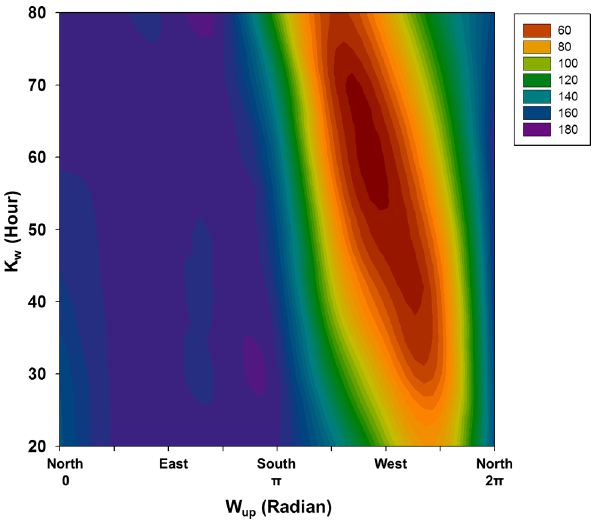
Figure 5. Sensitivity of the model to the integration period k s and wind direction W up . Contour plot of the standard deviation of the residuals between model and observation in m mol kg 2 1 DIC (color palette) for the September series as a function of W up , the azimuth of reference used as maximal weight, and the k w , the period of the running integration of the weighted wind series.